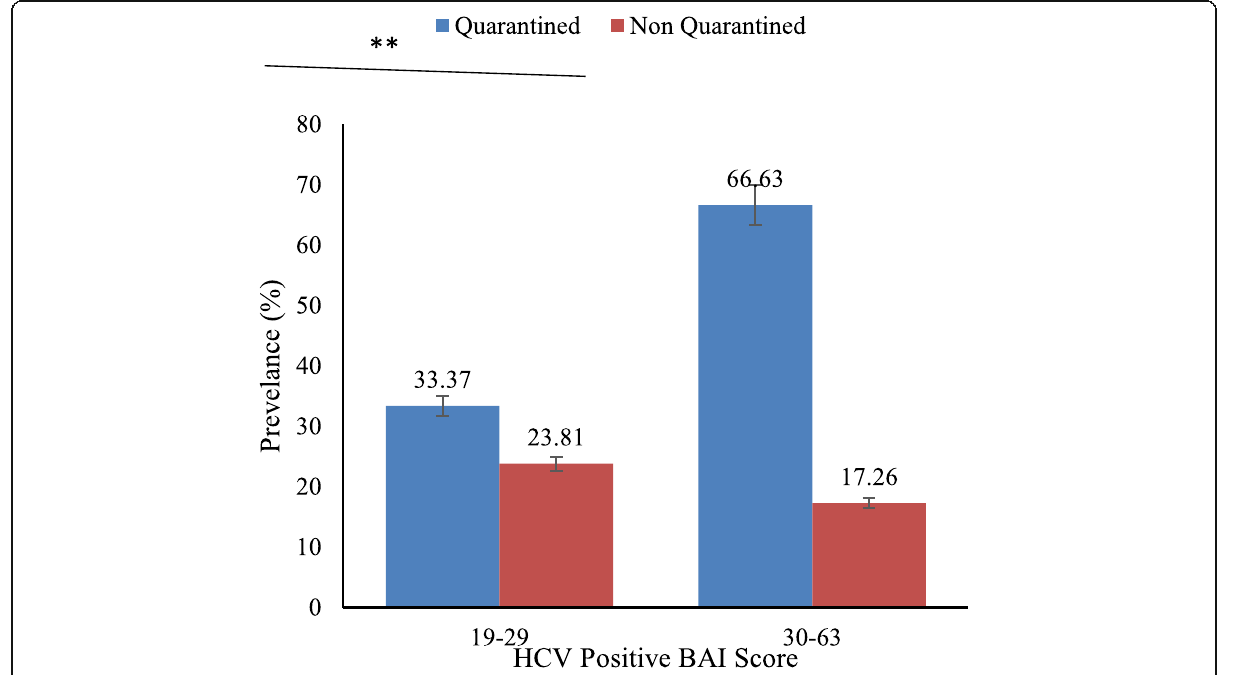
Fig. 3 Prevalence in HCV-positive quarantined vs HCV-positive non-quarantined patients